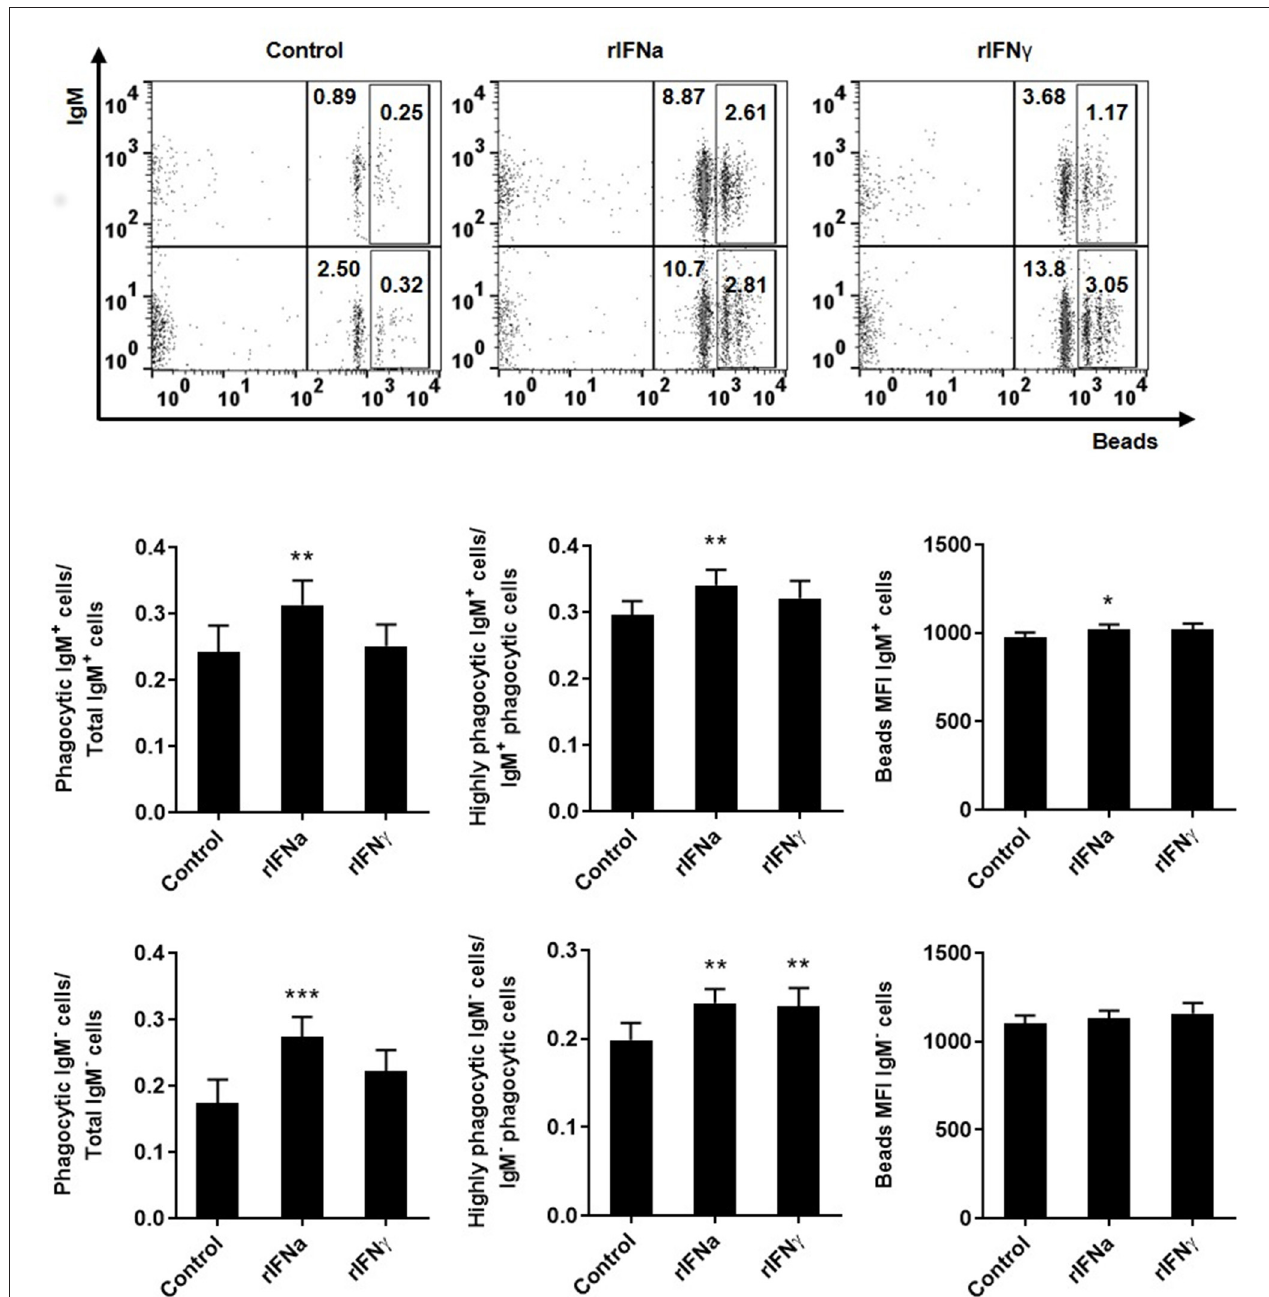
FIGURE 4 | Effect of type I and type II IFNs on the phagocytic capacity of blood IgM + IgD + B cells. PBLs were incubated for 72h at 20 ◦ C with 50ng/ml rIFNa, 20ng/ml rIFN γ or media alone (control). After this time, cells were incubated with crimson red fluorescent beads (1 µ m diameter) at a ratio of 1:10 (cells/ beads) for a further 3h at 20 ◦ C and the phagocytic capacity of B cells established as described in materials and methods. Representative dot plots for each experimental condition are shown. The rectangular areas contain the highly phagocytic cell subpopulations (cells that have internalized a higher number of beads) among IgM + (upper) or IgM − (lower) cell sub-populations. Upper graphs show the percentage of phagocytic IgM + B cells within the total IgM + B cell population (left), the percentage of highly IgM + phagocytic cells within the total phagocytic IgM + B cell population (middle) and the mean fluorescence intensity (MFI) of internalized beads within phagocytic IgM + B cells (right). Lower graphs show the same information for the IgM − population. Data are means + SEM; n = 10. Asterisks denote significant differences between samples treated with rIFNs and control samples (* P ≤ 0.05, ** P ≤ 0.01, *** P ≤ 0.001).